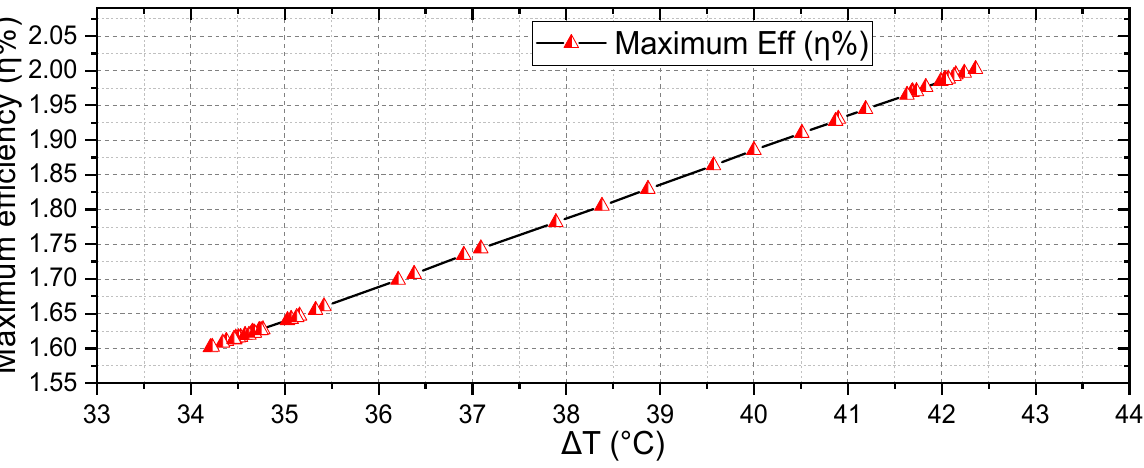
Figure 12. Efficiency of a 15 × 10 TEG panel system.